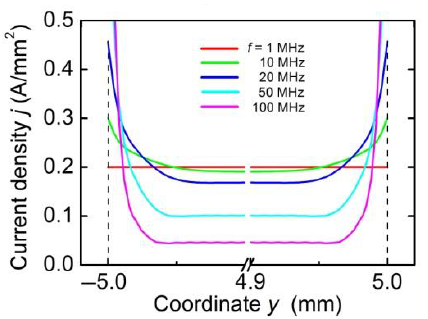
Figure 6. Current density distribution over the width of the Cu electrode for different current frequencies f from 1 MHz to 100 MHz.